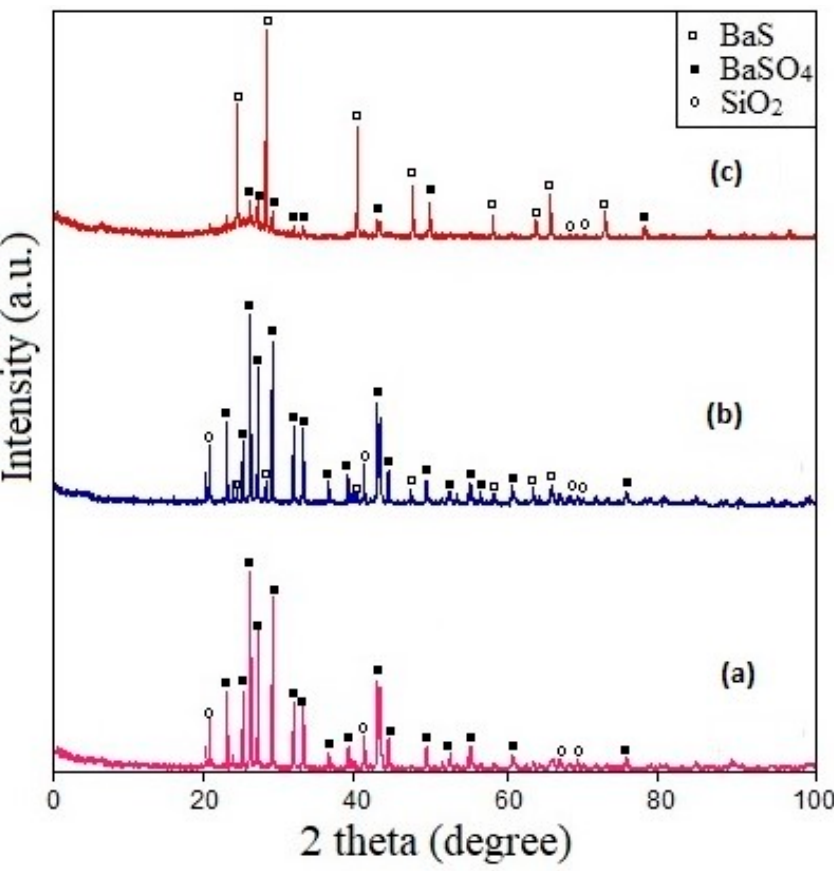
Figure 4. XRD patterns of unheated ( a ) and roasted (1150 °C, 18 min ( b ) and 1150 °C, 65 min ( c )) samples.